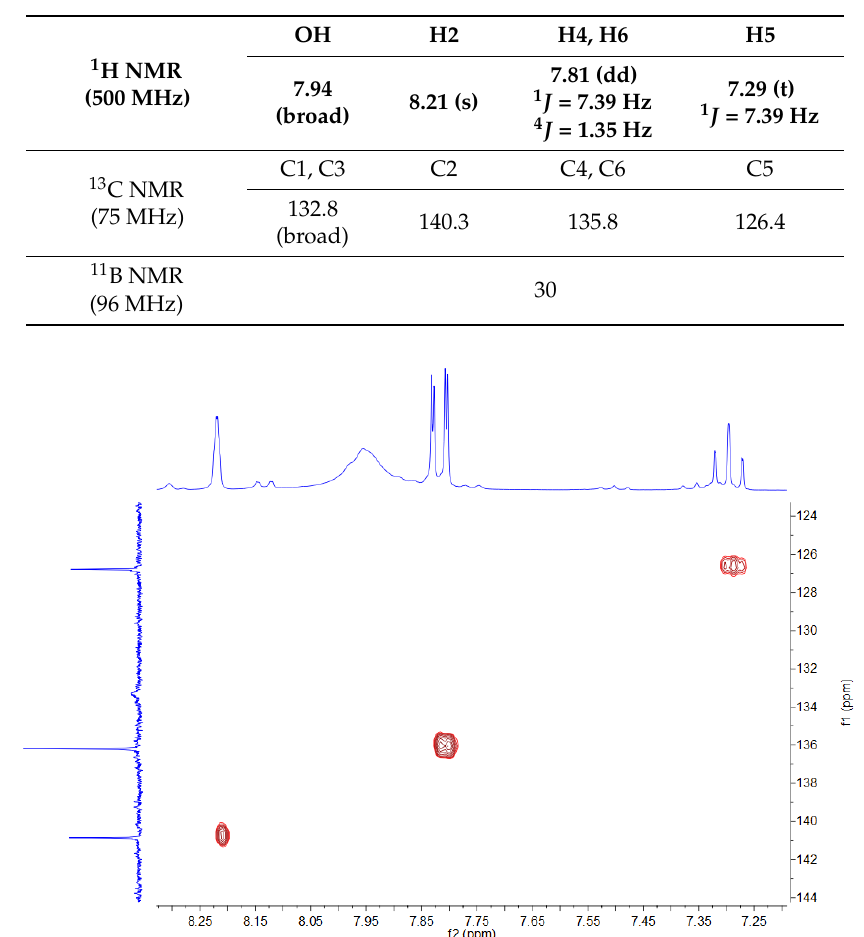
Table 2. Chemical shifts (ppm) and coupling constants ( J ) for 1,3-phenylenediboronic acid in DMSO- d 6 atom numbering scheme shown at Figure 3.